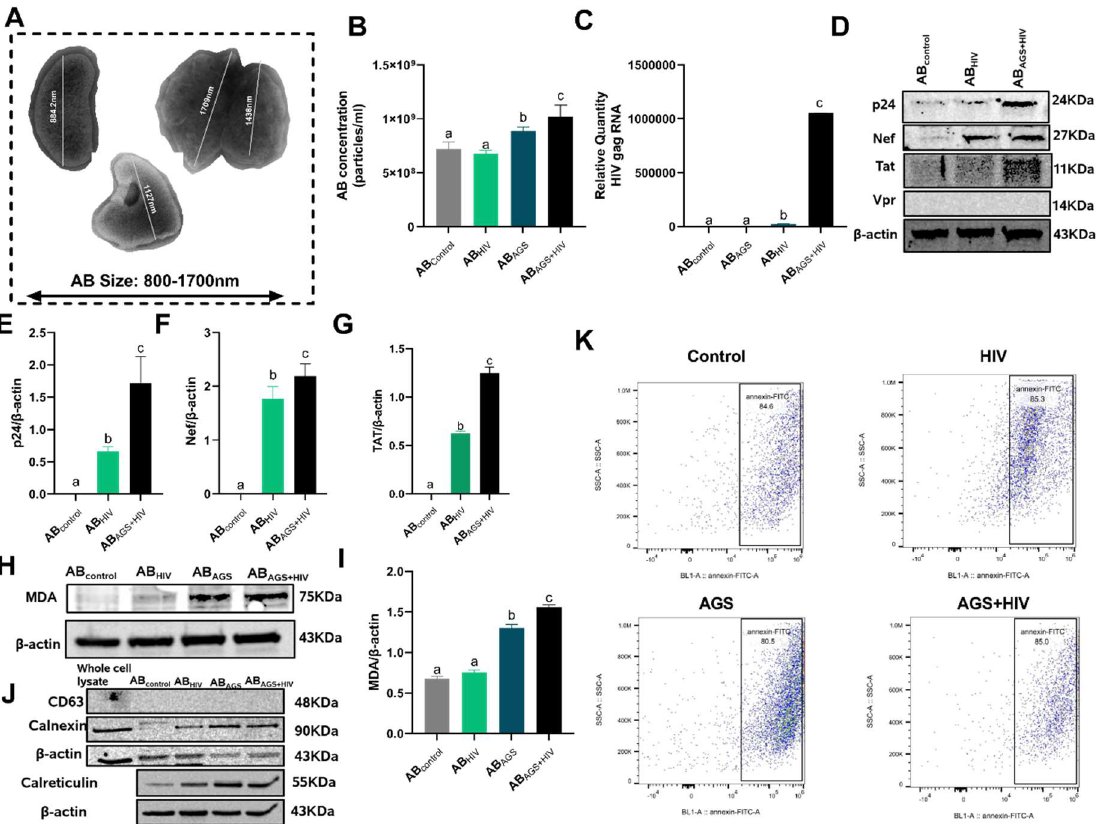
Figure 2. Characterization of ABs derived from acetaldehyde and HIV-exposed RLW: ( A ) Sizes of RLW ABs visualized by transmission electron microscopy. ( B ) Quantification of RLW ABs by NTA. ( C ) HIV gag RNA expression in RLW ABs quantified by RT-PCR analysis. ( D ) HIV proteins: p24, Nef, and Tat in RLW ABs were measured by immunoblotting analysis. Equal amounts of protein (20 µg) were loaded in each lane. β-actin was used as an internal control. ( E – G ) Quantification of the immunoreactive bands of HIV proteins: p24, Nef, and Tat in RLW Abs. ( H , I ) Malondialdehyde (MDA) content in RLW ABs was measured by immunoblotting analysis and quantification of immunoreactive protein bands was provided. Equal amounts of protein (20 µg) were loaded in each lane. β-actin was used as an internal control. ( J ) Exosome marker (CD63) and AB markers (calnexin and calreticulin) were measured by immunoblotting analysis of RLW AB lysate. Equal amounts of protein (20 µg) were loaded in each lane. ( K ) Quantification of phosphatidylserine surface expression on RLW ABs measured by flow cytometry. Western blot detected bands were from the representative experiments. Statistically processed data are from 3 independent experiments presented as mean ± SEM. Bars marked with the same letter are not significantly different; bars with different letters are significantly different from each other ( p ≤ 0.05).